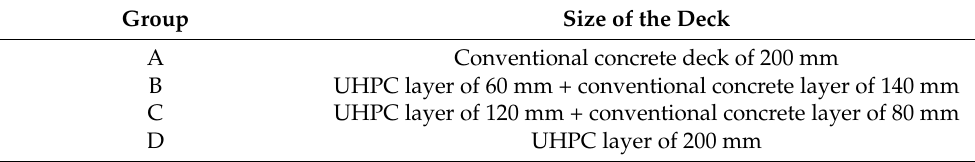
Table 1. Specimen